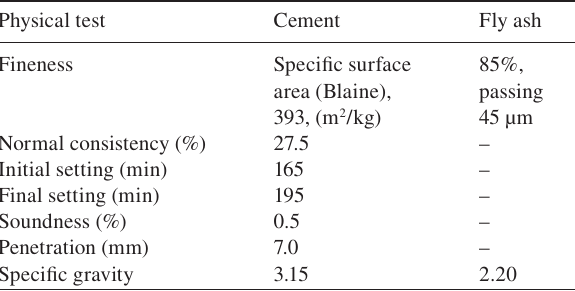
Table 2 Physical properties of Portland cement and class F fl y ash.